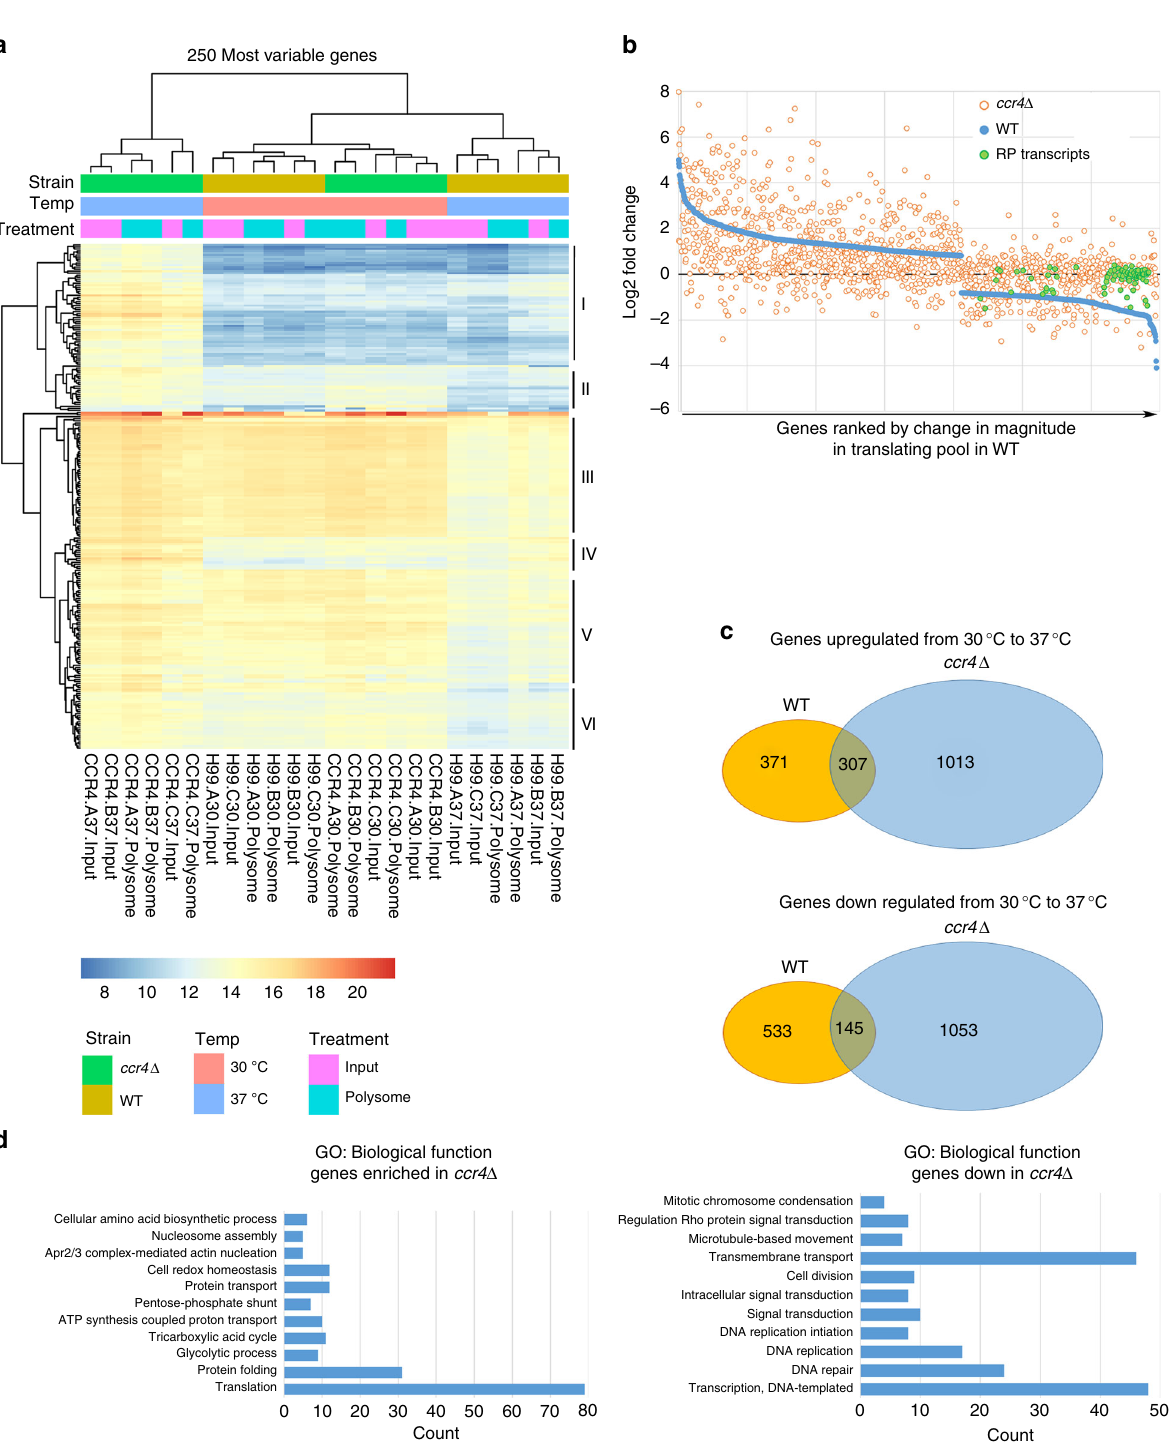
Fig. 4 mRNA decay is required for reprogramming the translatome and transcriptome. a Heatmap of expression levels for the top 250 most variable genes in our total data set. The color scale de fi nes the measured expression of a given gene. b Genes with signi fi cant change in the polysomal fractions following a shift from 30 °C to 37 °C in the wild-type identi fi ed by RNA-Seq were plotted in order of log2 magnitude change (blue circles). The magnitude of change for each corresponding gene in the ccr4 Δ mutant was overlaid (orange circles). RP genes are highlighted in green. c Venn diagrams demonstrate genes that are upregulated and downregulated in response to host temperature in WT and the ccr4 Δ mutant following growth at 37 °C for 1 h. d GO analyses for genes differentially expressed in the ccr4 Δ mutant compared with wild-type 1 h after a shift to host